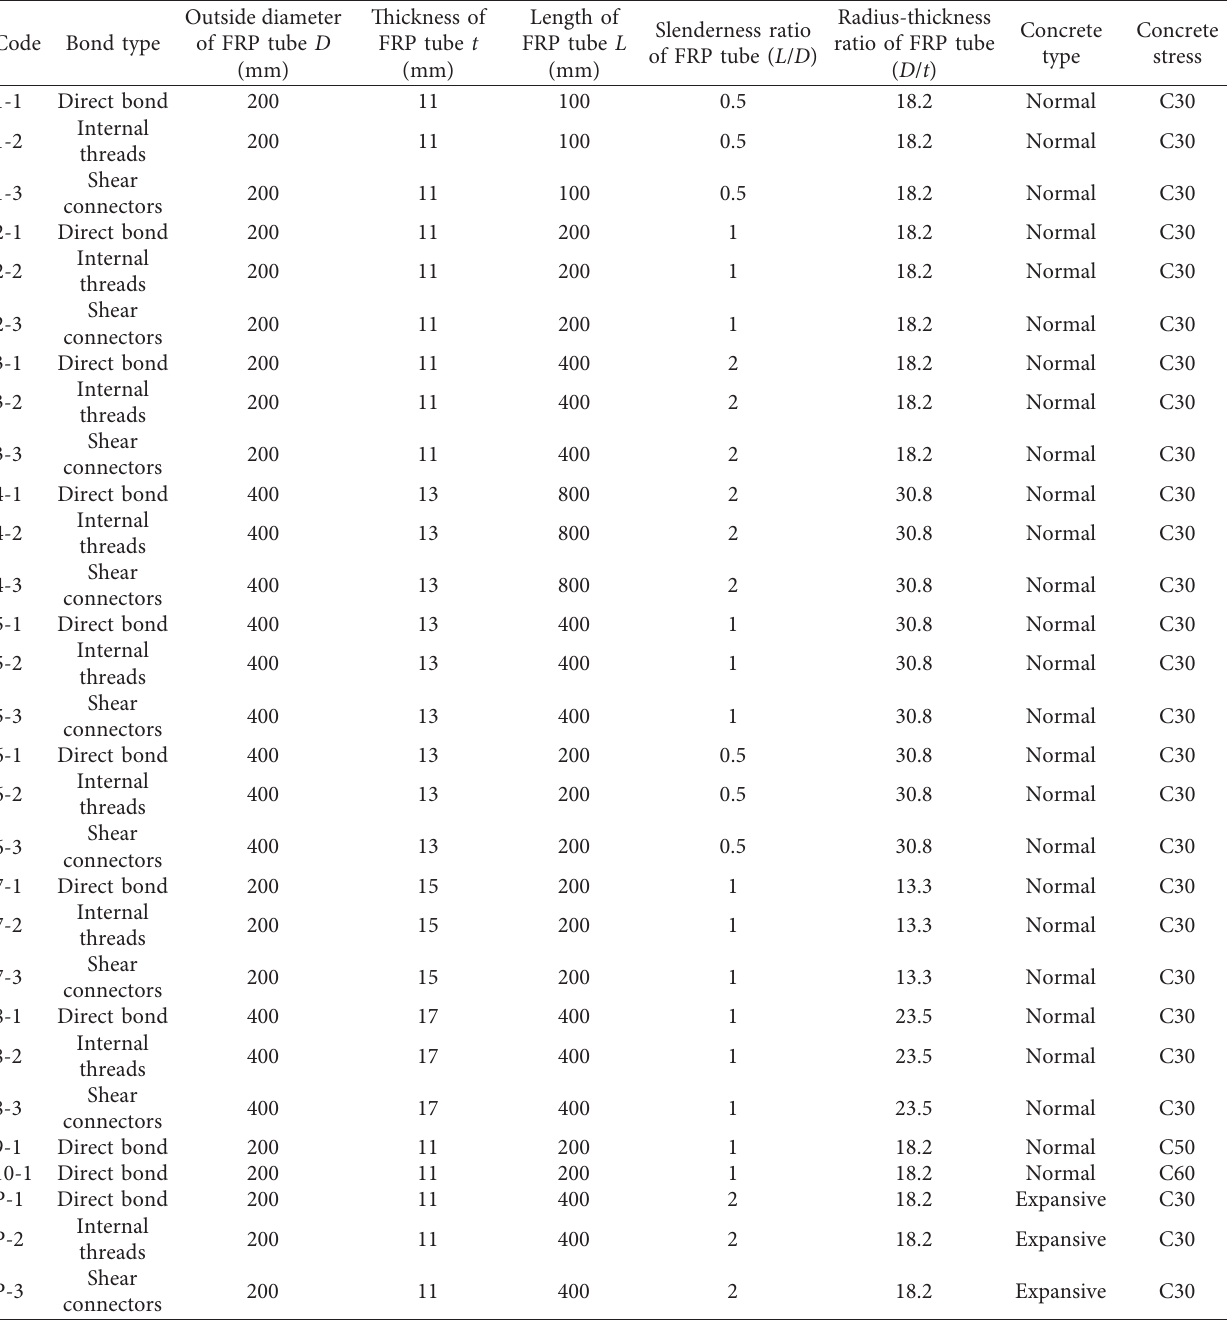
Table 1: Parameters of